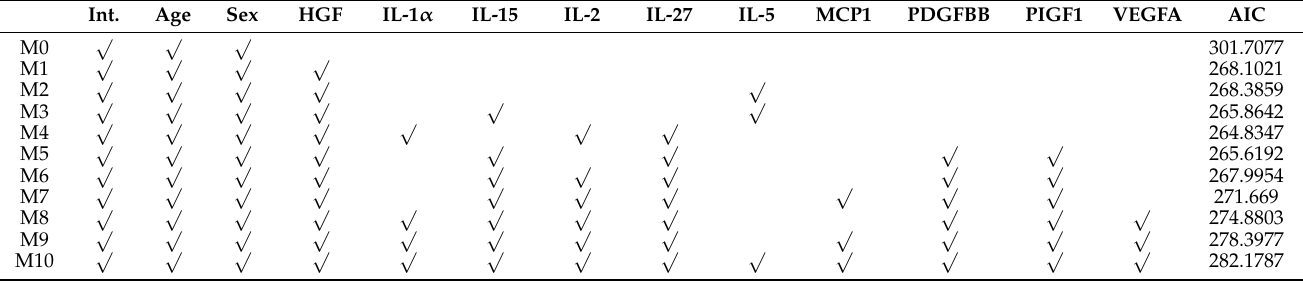
Table 2. Identification of the best multivariable model following AIC (“Akaike’s Information Criterion”). Int.